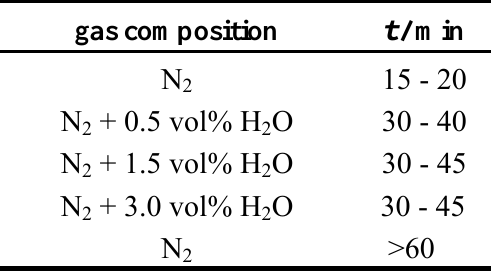
Table 1. Exemplary test procedure to evaluate the impedimetric sensor response of MOF O concentrations in N carrier gas. Flow rate: 300 mL/min. materials at different H 2 2 Temperature range: 120 °C - 240